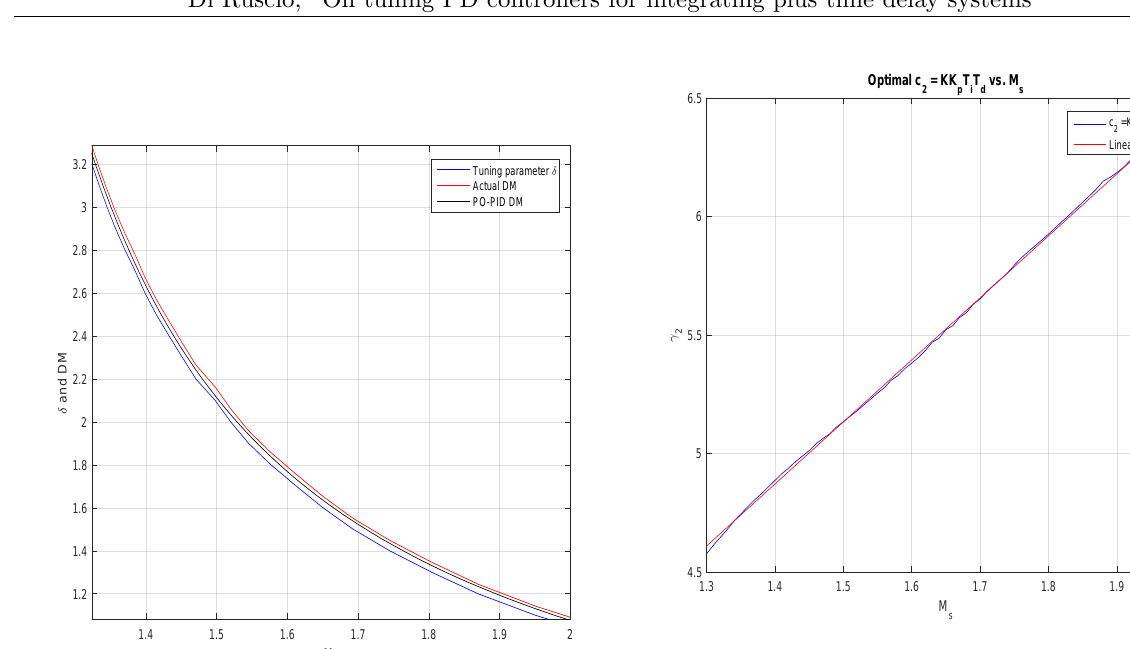
Figure 13: Linear approximation for c 2 = KK p T i T d vs. M s , for the POI-PID, i.e. c 2 = 2 . 6167 M s +